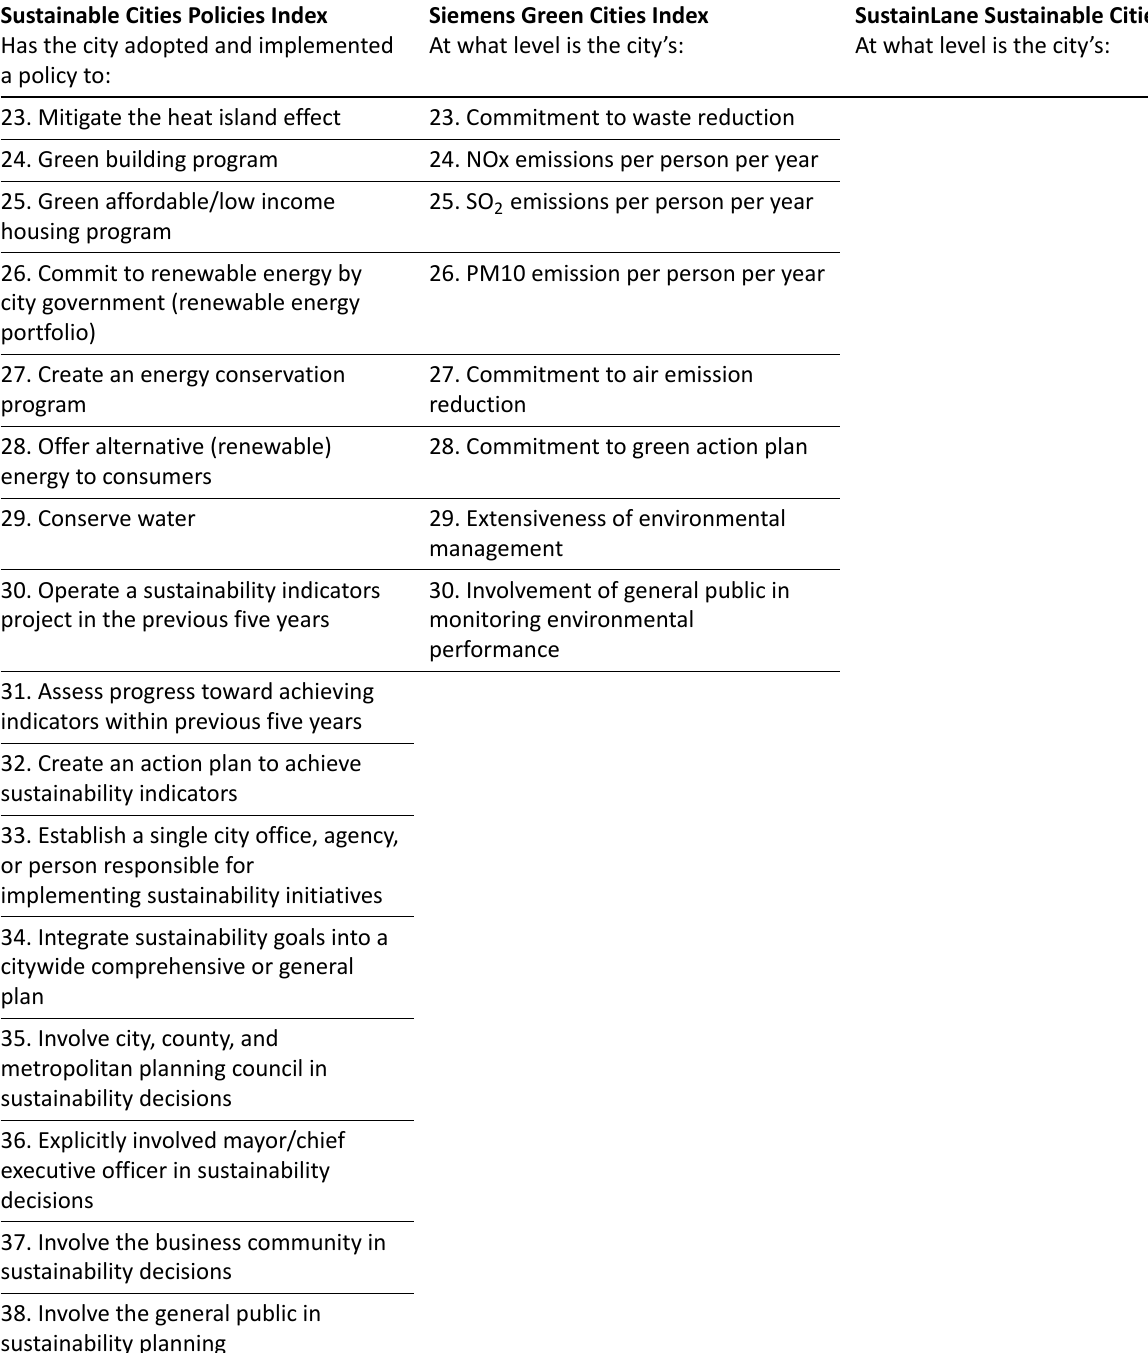
Table 1. Comparison of three measures of city sustainability. (Cont.) Sustainable Cities Policies Index Siemens Green Cities Index SustainLane Sustainable Cities Score Has the city adopted and implemented At what level is the city’s: At what level is the